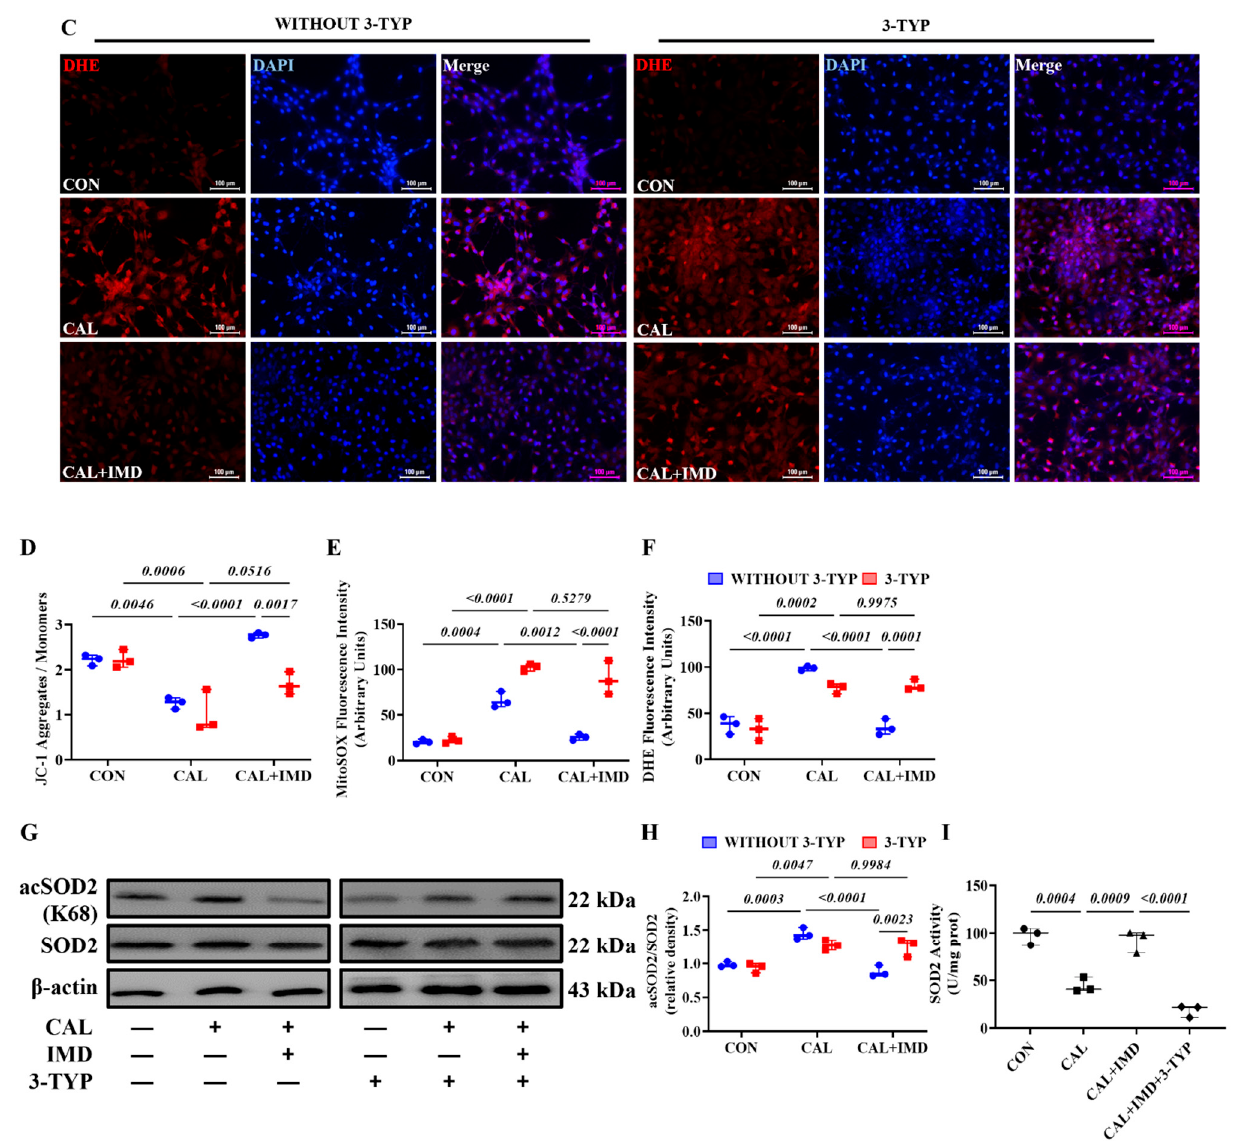
Figure 5. The Sirt3 inhibitor 3-TYP blocked IMD improving mitochondrial function of calcified VSMCs. ( A ) JC-1 probing mitochondrial membrane potential in rat VSMCs (red: JC-1 aggregates, green: JC-1 monomers). Merged images are shown (Scale bar = 50 μ m). ( B ) MitoSOX Red probing mitochondrial ROS in rat VSMCs (positive staining: red). Nuclei were stained with DAPI (blue). Merged images are shown (Scale bar = 100 μ m). ( C ) DHE probing intracellular ROS in rat VSMCs (positive staining: red). Nuclei were stained with DAPI (blue). Merged images are shown (Scale bar = 100 μ m). ( D ) Ratio of the average fluorescence intensity of JC-1 aggregates to JC-1 monomers ( n = 3). ( E ) Average fluorescence intensity of MitoSOX in rat VSMCs ( n = 3). ( F ) Average fluorescence intensity of DHE in rat VSMCs ( n = 3). ( G ) Western blot analysis of the protein levels of acetylation- SOD2 (K68) and SOD2 in rat VSMCs and ( H ) quantification of the acetylation-SOD2 to SOD2 ratio ( n = 3). ( I ) SOD2 activity in rat VSMCs ( n = 3). CON (circles in (I)): control VSMCs, CAL: (squares in (I)) calcification VSMCs, CAL + IMD (triangles in (I)): calcification VSMCs with IMD 1-53 treatment, CAL + IMD + 3-TYP (diamonds in (I)): calcification VSMCs with 3-TYP pretreatment and IMD 1-53 treatment. 3-TYP (blue circles in (D-F) and (H): VSMCs with 3-TYP pretreatment, WITHOUT 3-TYP (red squares in (D-F) and (H)): VSMCs without 3-TYP pretreatment. Data are mean ± SD. 3.3. IMD Upregulated Sirt3 by Activating Its Receptor and the AMPK Pathway IMD exerts biological effects through its receptor complex CRLR/RAMPs and the post-receptor signaling pathway[3,14]. First, to elucidate whether IMD regulates Sirt3 via